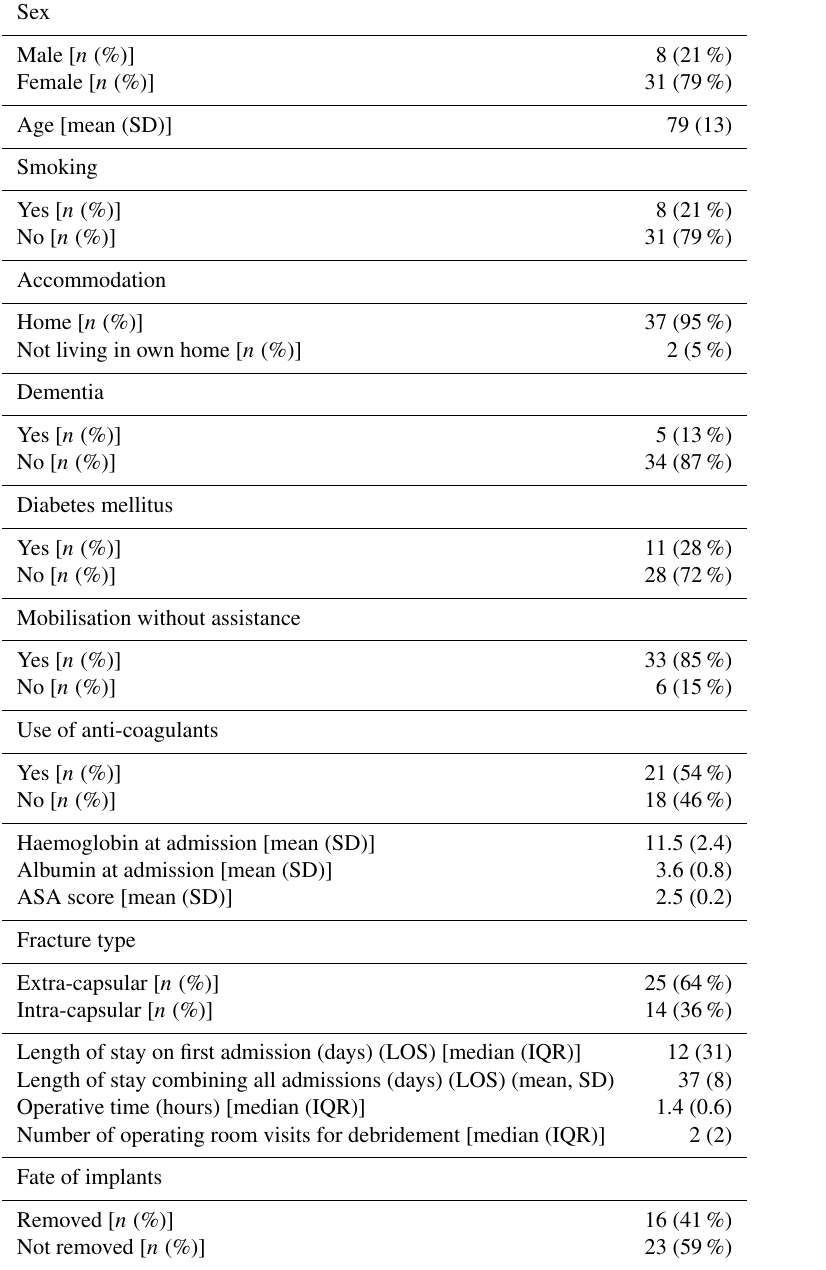
Table 1. Demographics of the group of patients that complicated with infection after fracture